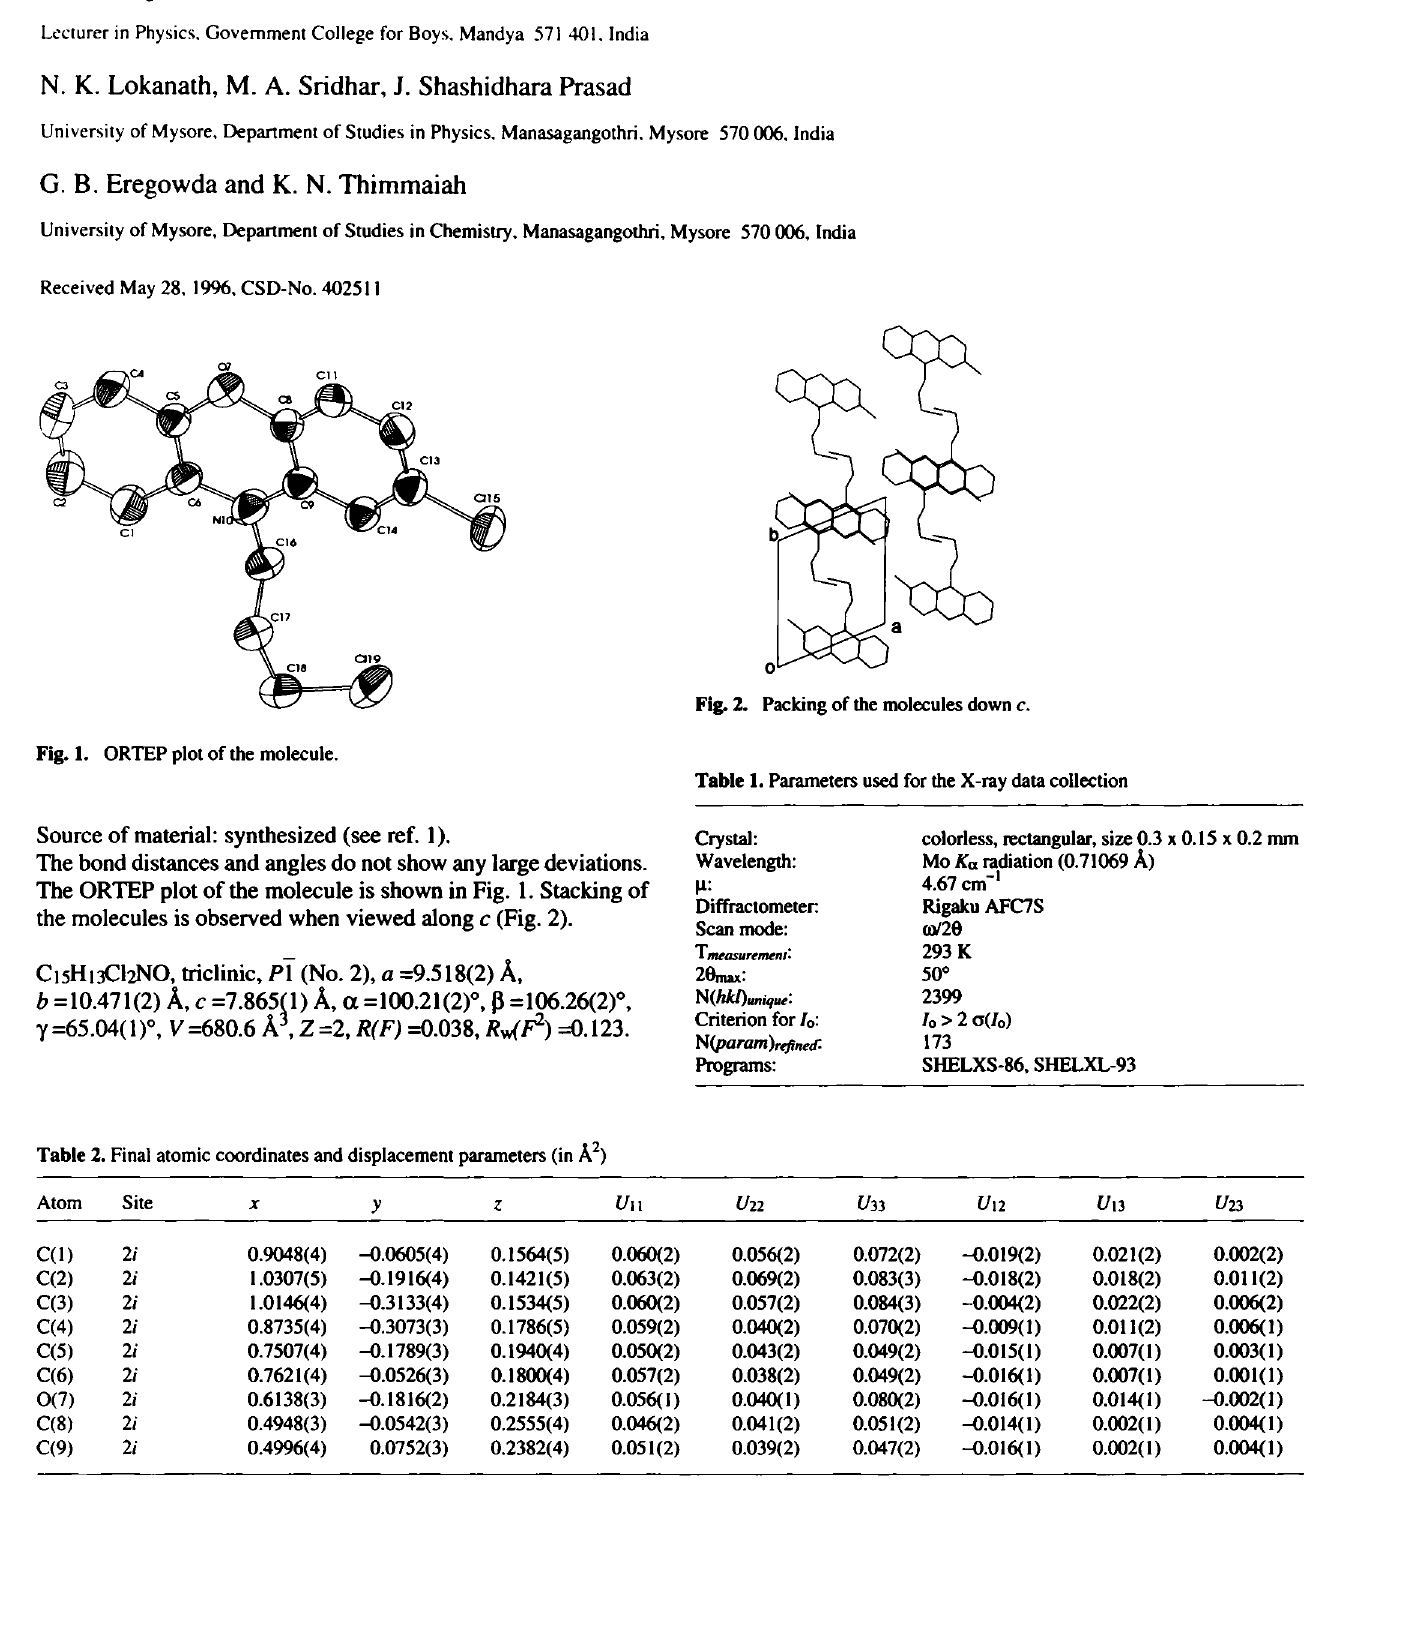
C15H13CI2NO, triclinic, P\ (No. 2), a =9.518(2) Â,